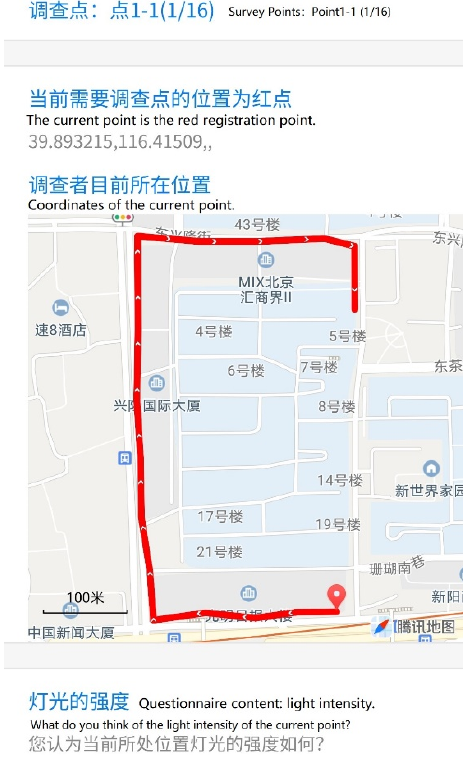
Figure 10. Guide map of routes and survey points in the applet interface (Because the applet is used in Wechat applications in China, the built-in map and questionnaire are in Chinese).